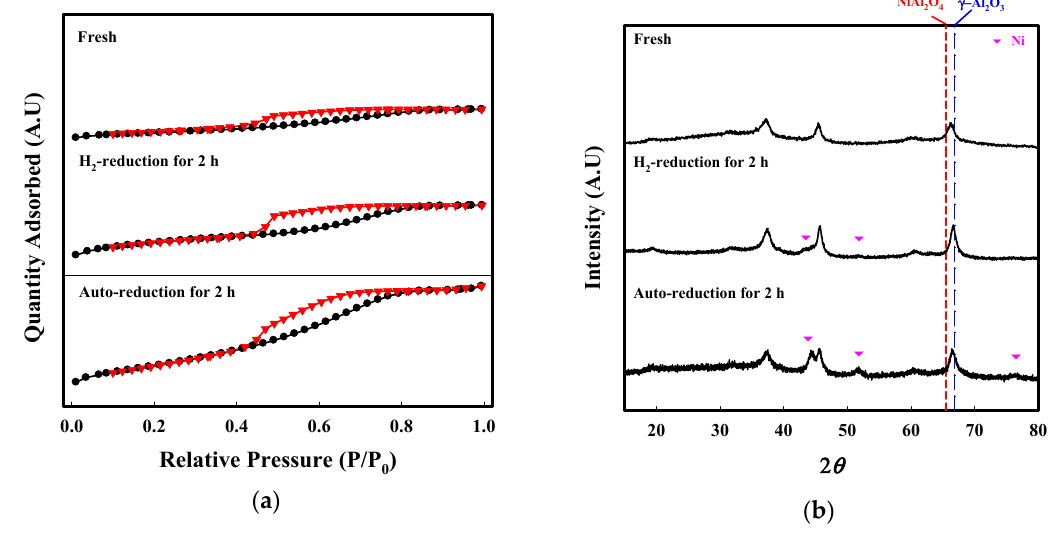
Figure 3. ( a ) Nitrogen adsorption-desorption isotherms and ( b ) XRD patterns of the fresh and reduced NA10-PM, activated by conventional H 2 reduction and by auto-reduction at 750 °C for 2 h. Table 1. Textural properties of fresh and reduced NA10-PM catalyst activated by conventional H 2 -reduction and by auto-reduction at 750 °C for 2 h.